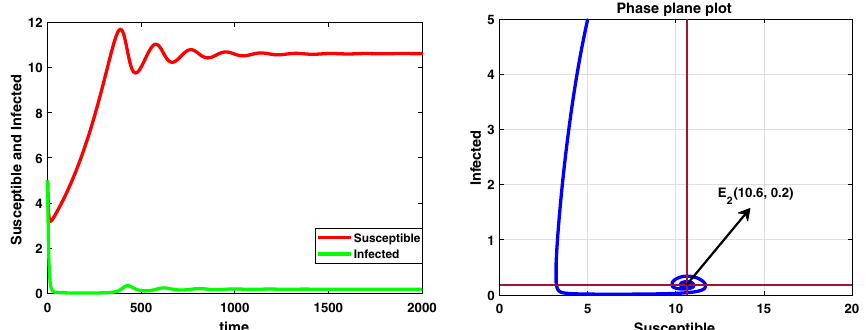
Fig. 9 A dynamical behaviour of system (4) with r > µ and the corresponding two-dimensional phase portrait of S,I with susceptible and infected isocline about endemic equilibrium point E